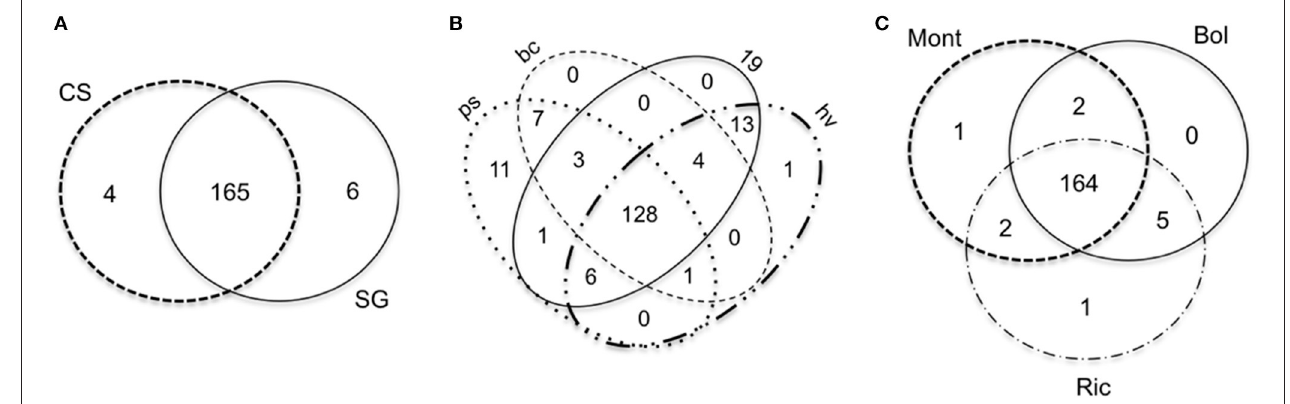
FIGURE 8 | Venn diagrams comparing the miRNAs expressed in small RNA libraries of Vitis vinifera constructed using berries. The venn diagrams are divided by (A) , cultivar; (B) , developmental stage; (C) , environment. Bol, Bolgheri; Mont, Montalcino; Ric, Riccione; CS, Cabernet Sauvignon; SG,